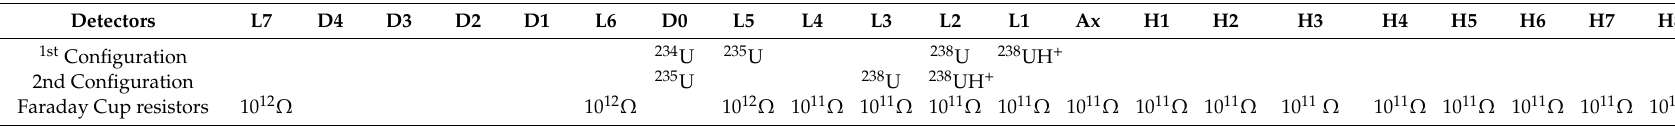
Table 6. Configuration of collectors in